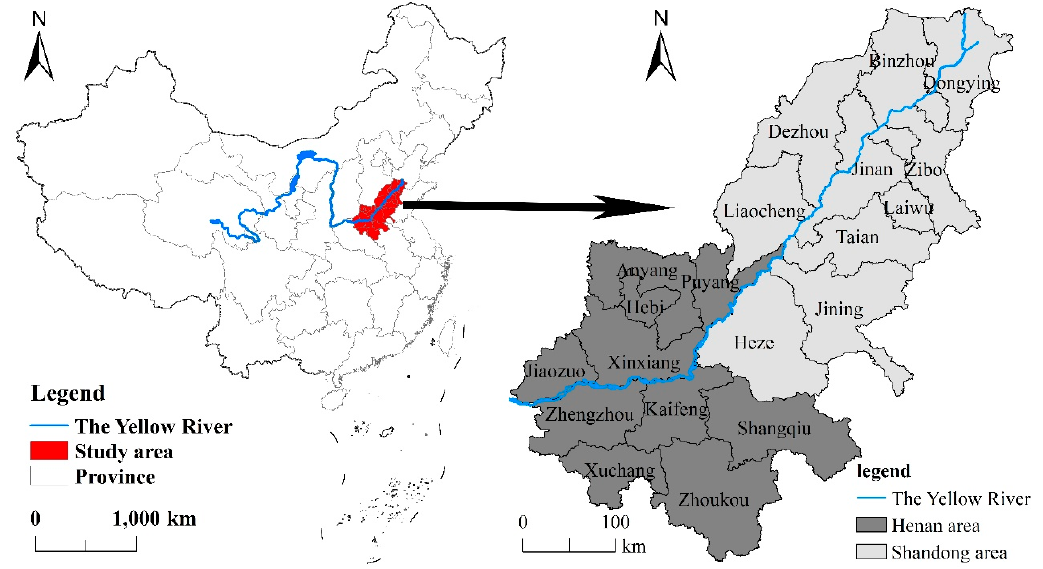
Figure 1. Location of the study area.